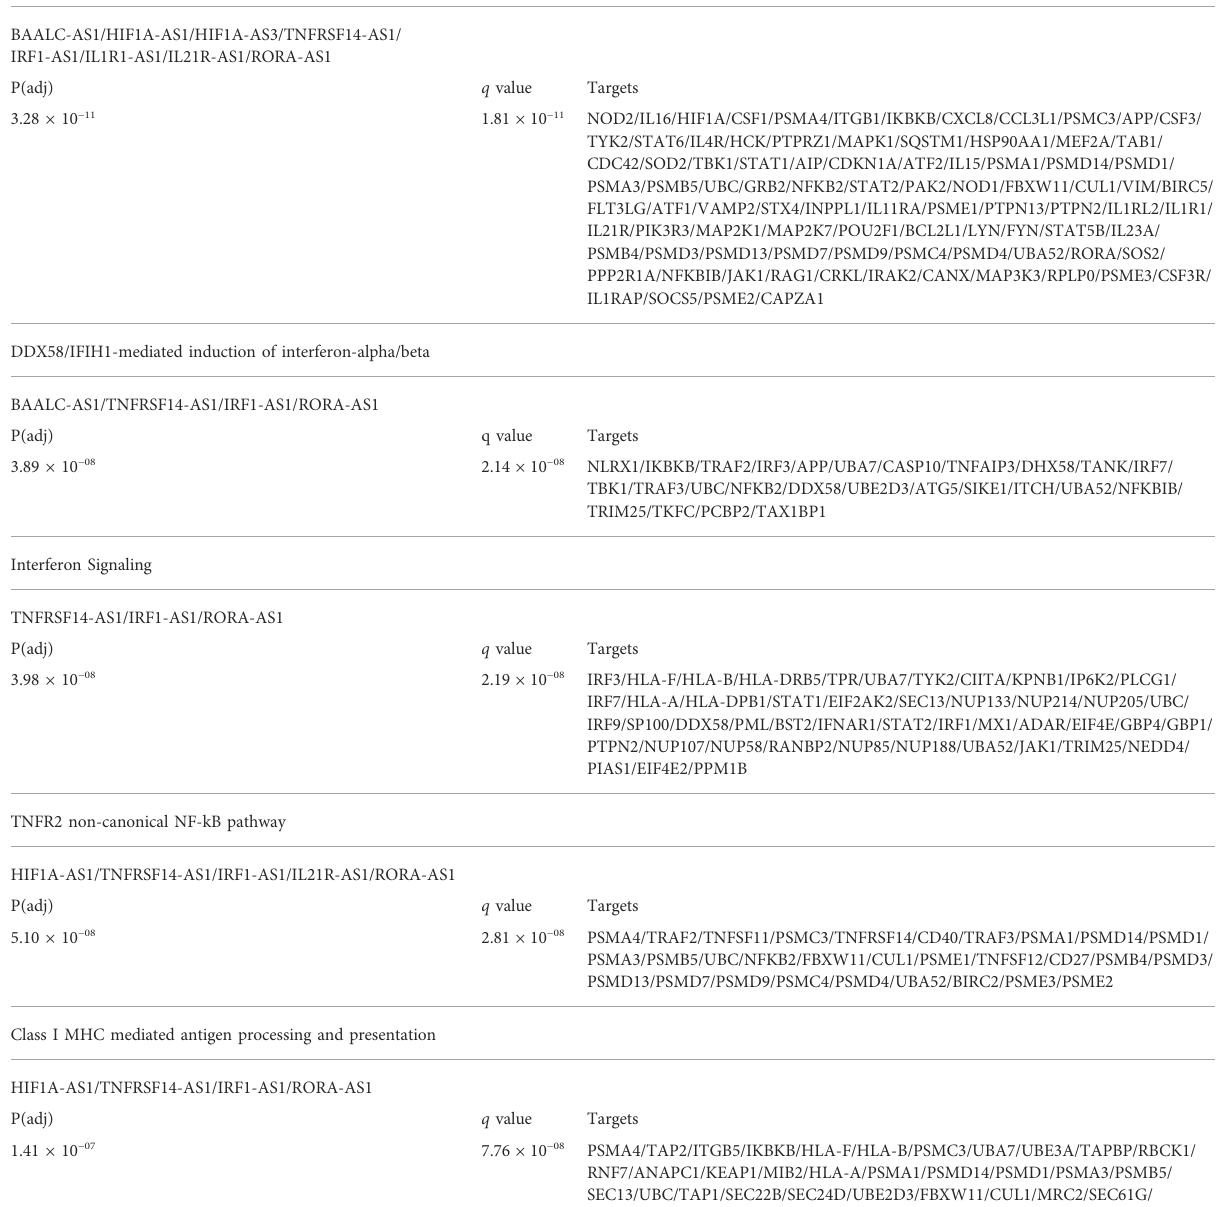
TABLE 2 Enrichment analysis of putative lncRNA targets from NcPath database. Signaling by